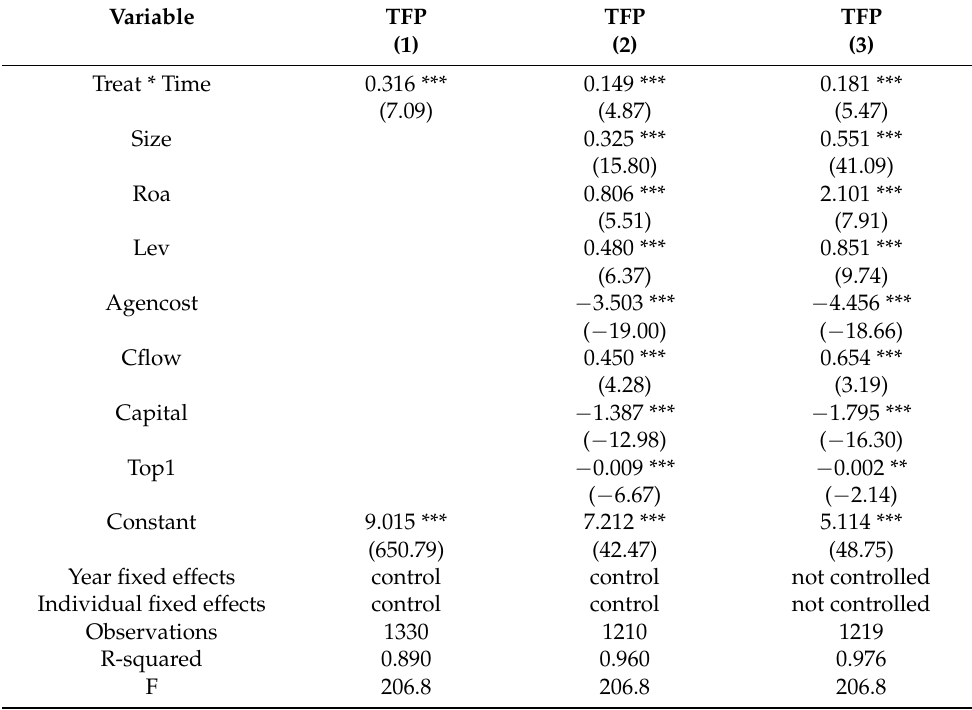
Table 3. Basic regression